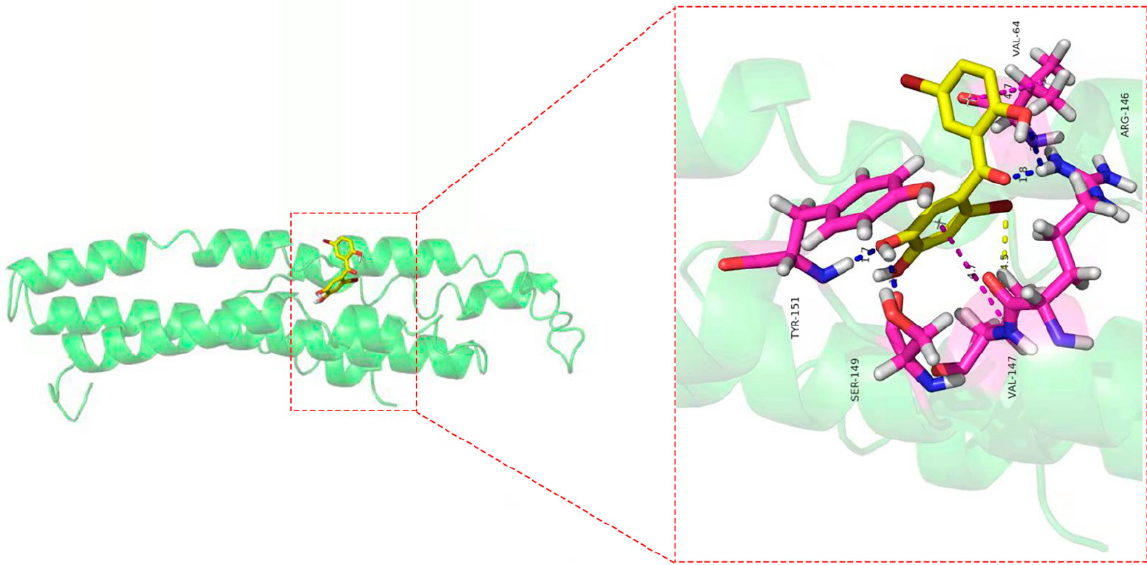
Figure 9. The docking results of TDD to CAV-1 protein: blue lines represent the hydrogen bond, yellow lines represent the hydrophobic effect, and blue lines represent the π - π bond in the picture.